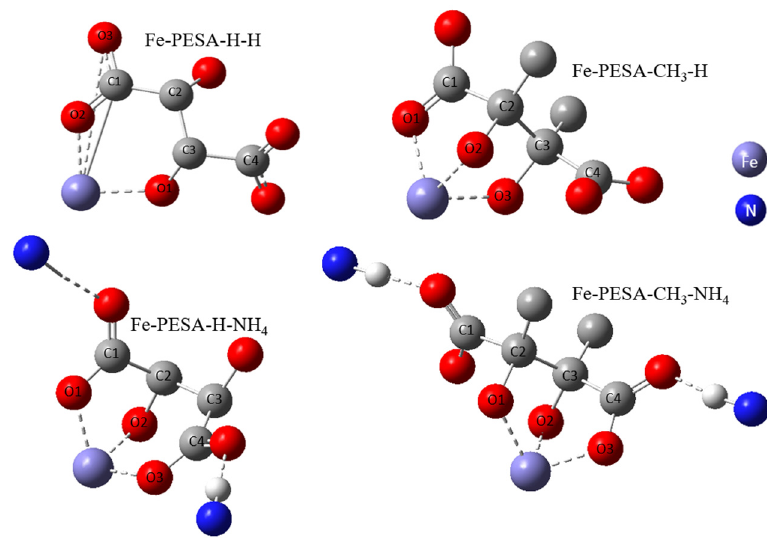
Figure 2. The optimized structure of Fe complex with 1-monomers of PESA molecule .